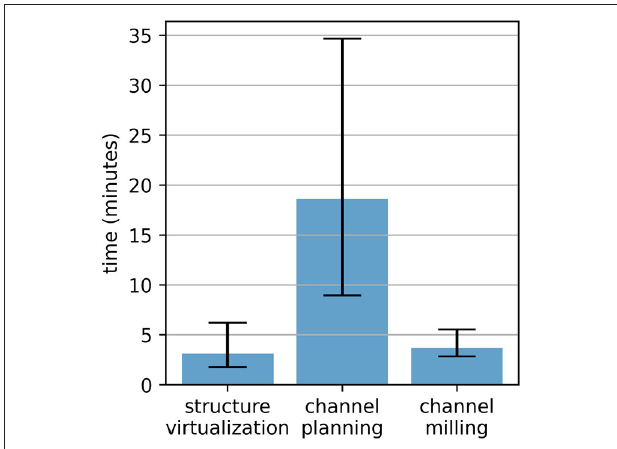
robotic milling of the implant bed for the